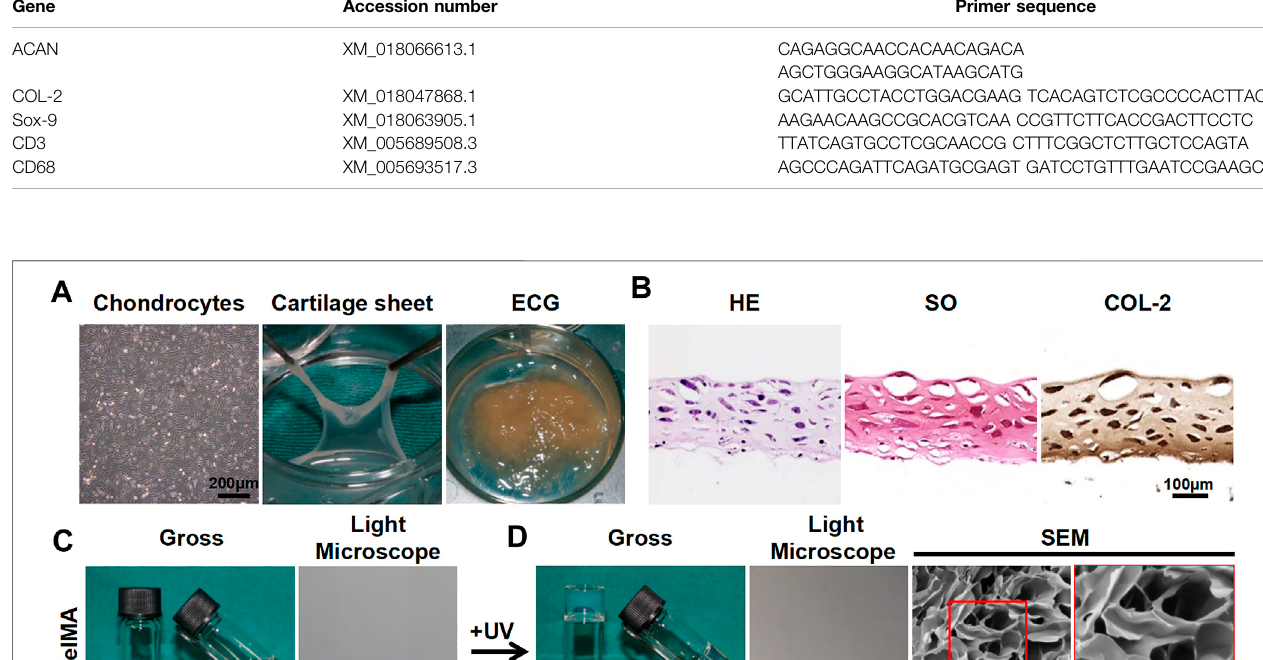
Frontiers in Bioengineering and Biotechnology |